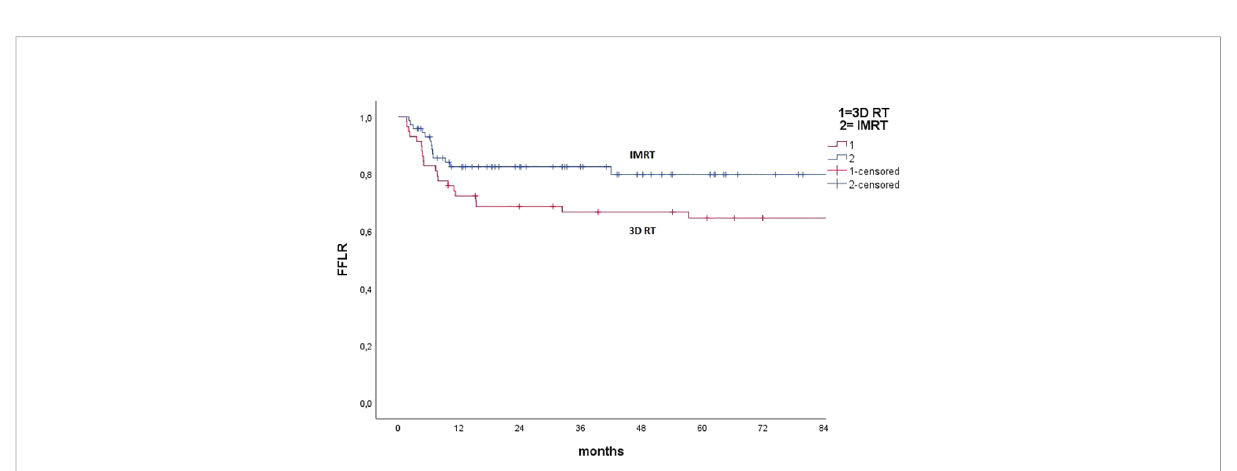
FIGURE 2 Kaplan – Meier curve concerning freedom from local recurrence for pts treated with 3D conformal Radiotherapy (3D RT) versus IMRT (all